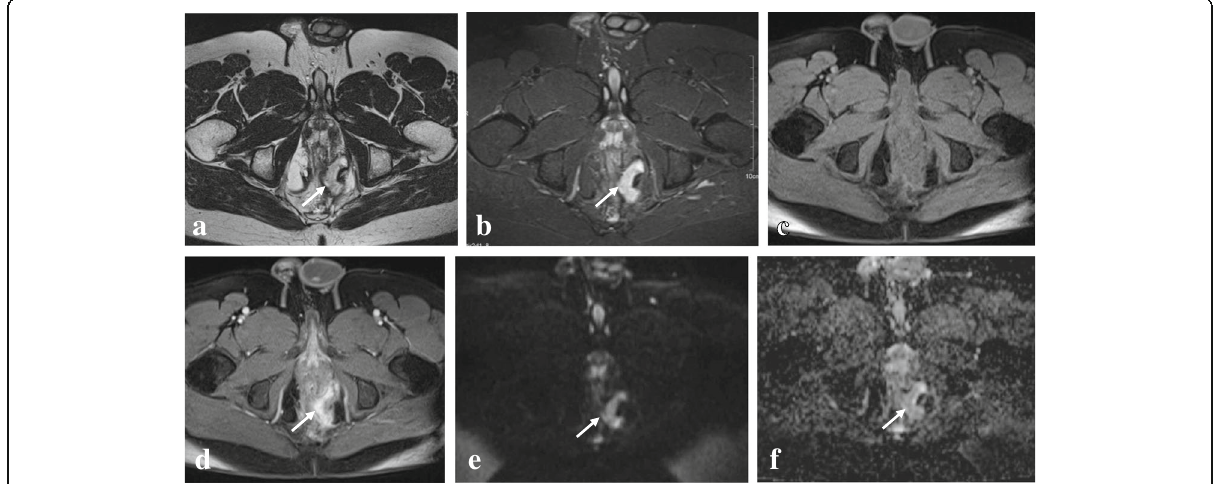
Fig. 8 A 26-year-old man with supra-sphincteric fistula with abscess. a Axial T2-weighted image shows C-shaped left perianal abscess (arrow) that exhibits high signal intensity. b Axial STIR-weighted image reveals high signal intensity of the perianal abscess (arrow). c Axial T1 fat-saturated weighted image the perianal abscess is not visualized. d Axial T1 fat-saturated post-contrast injection weighted image reveals intense contrast enhancement of the perianal abscess (arrow). e Axial diffusion-weighted image reveals high signal intensity of the perianal abscess (arrow). f Axial ADC mapping shows high signal intensity of the perianal